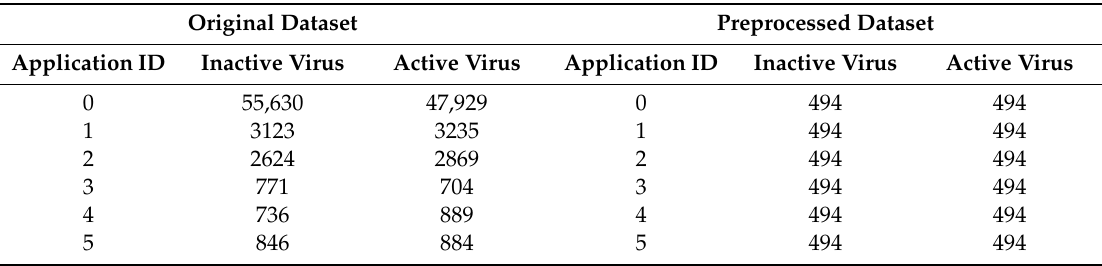
Table 2. Summary of